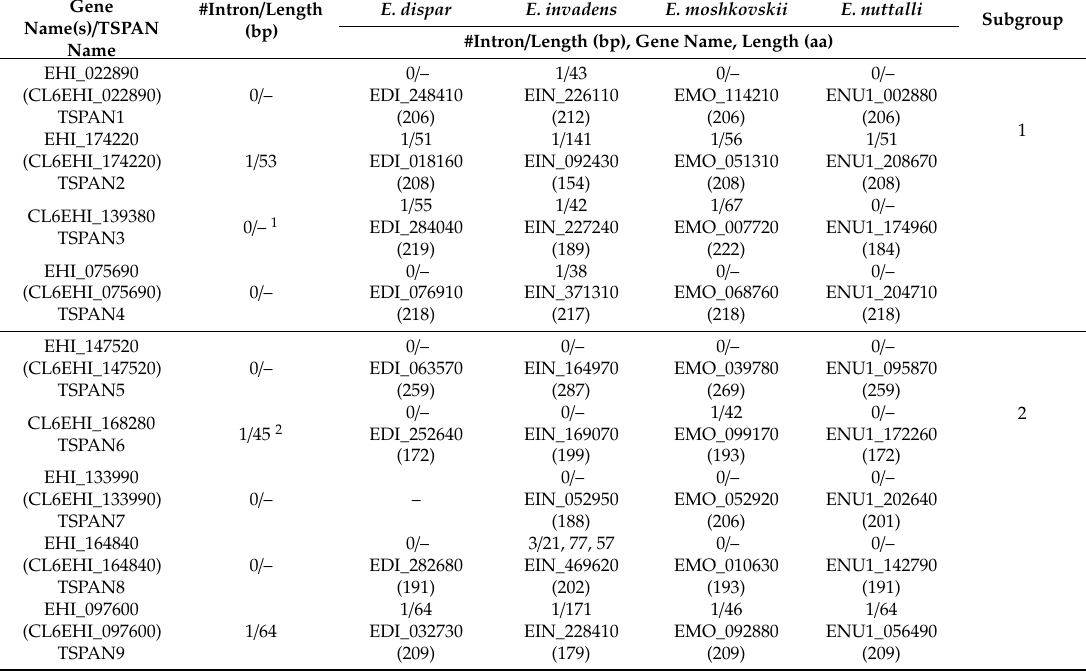
Table 3. Orthologous relationships and gene organizations of tetraspanins in Entamoeba